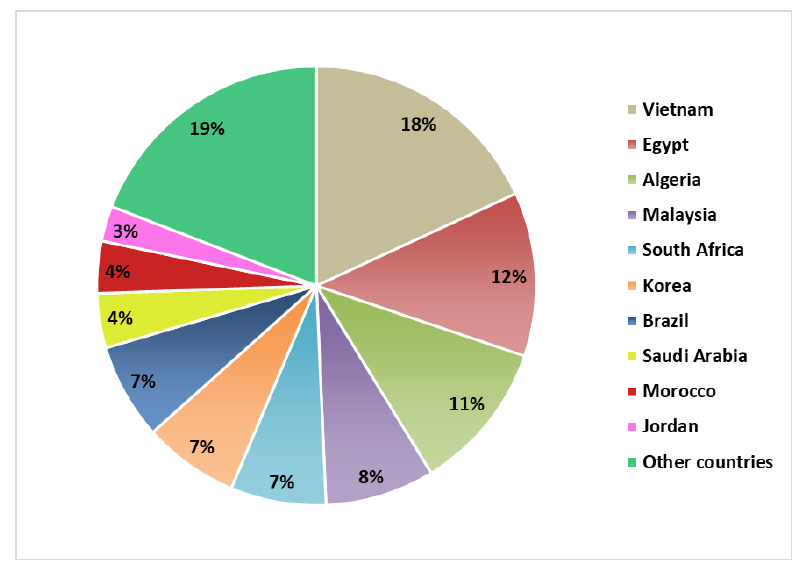
Figure 6. International destinations of maize from Argentina in 2016–2017.